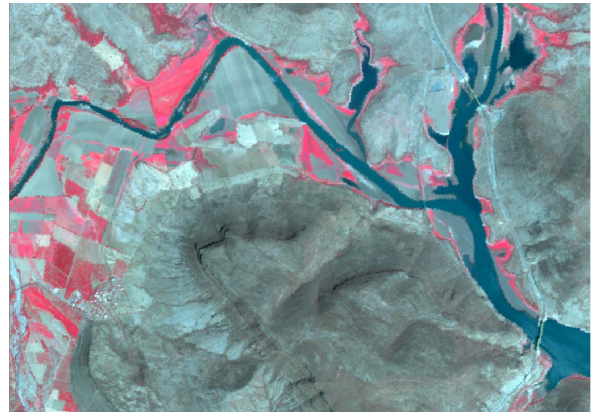
Figure 4: False color composite of the SPOT 5 Image, 2007. c (cid:13) CNES.